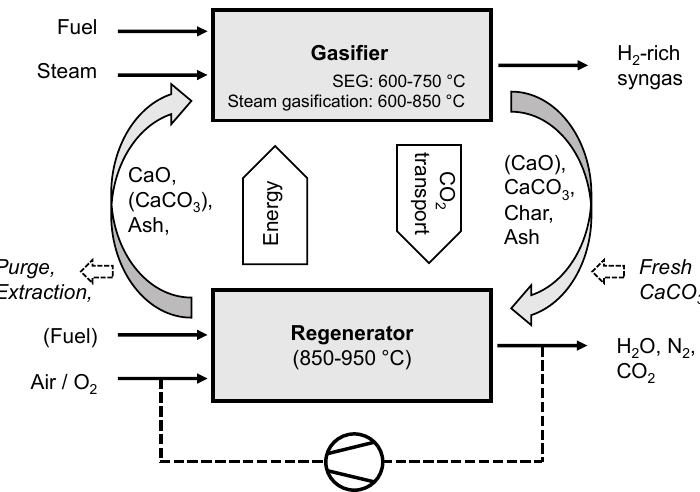
Figure 1. Schematic diagram of sorption enhanced gasification (SEG) process (up to 750 °C) and extended steam gasification mode (up to 850 °C); option of oxy-fuel operation.